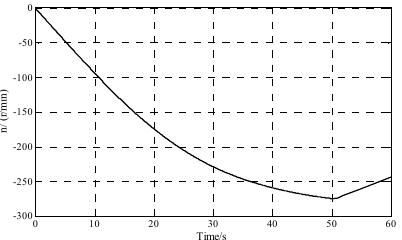
Figure 13. Speed waveform during start-up stage.